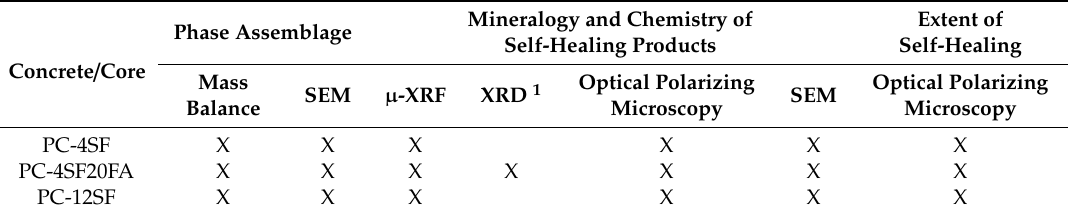
Table 4. Overview of experimental methods used to investigate the phase assemblage of the hydrated binders, the chemical and mineralogical composition of self-healing products, and the extent of